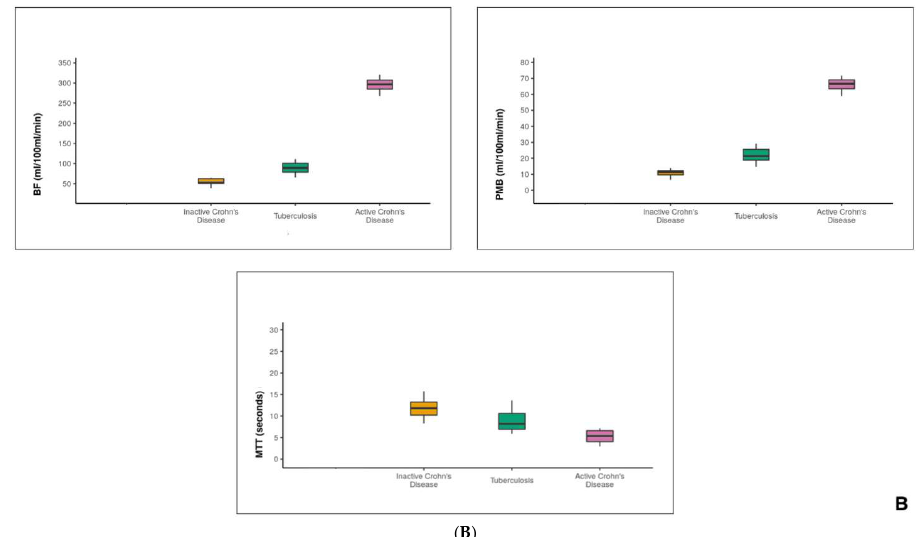
Figure 2. ( A ) Graphical depiction showing the trend followed by the perfusion parameters. ( B ) Corresponding box and whisker plots. There is an increasing gradient in blood flow (BF) and permeability (PMB) from inactive CD to gastrointestinal tuberculosis to active CD. A reverse gradient is noted for mean transit time (MTT). (BF: Blood Flow, BV: Blood Volume, MTT: Mean Transit Time, PMB: Permeability, TB: Tuberculosis).